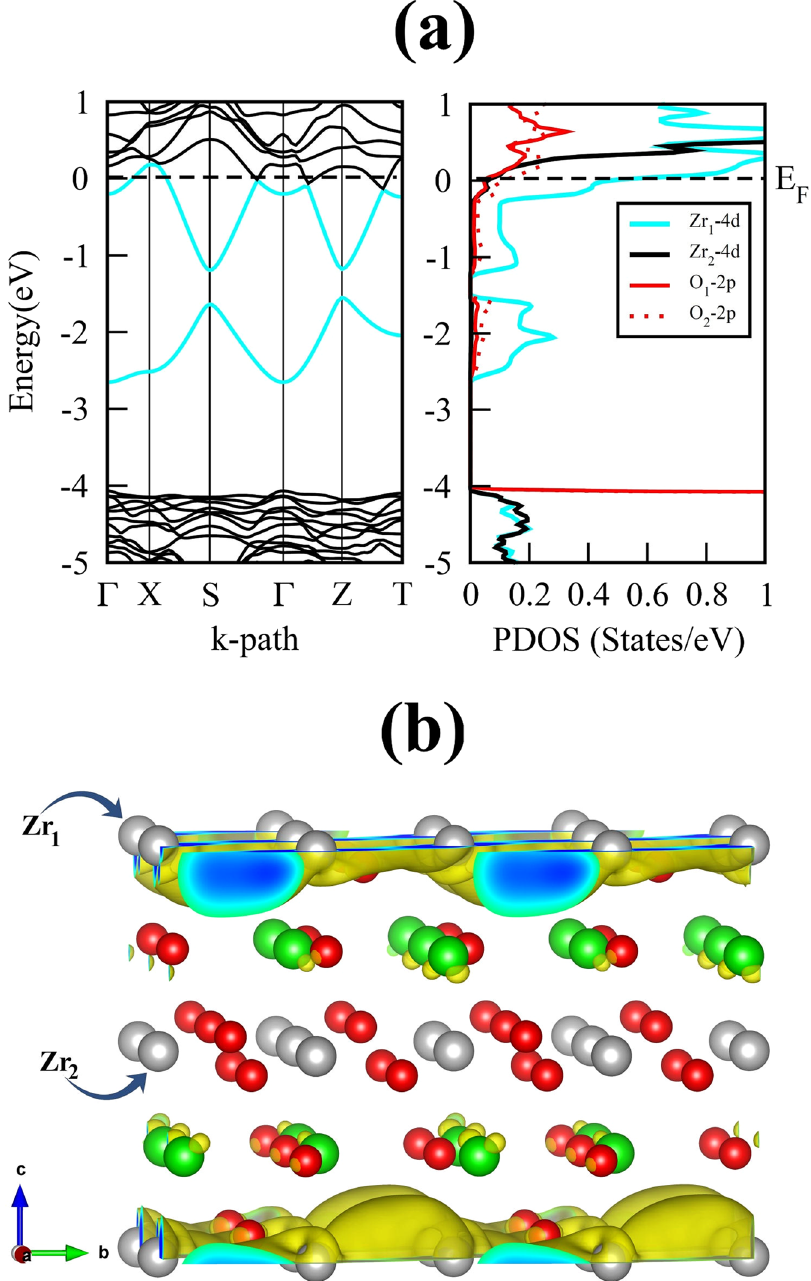
Figure 9. The calculated electronic properties and 3D valence charge density isosurfaces for V 2 × 1 × 2 supercell of CaZrO 3 . The 3D valence charge density isosurfaces are calculated with an isosurface level of 0.005 a.u . − 3 for the electronic states ranging from − 1.30 eV up to the E F